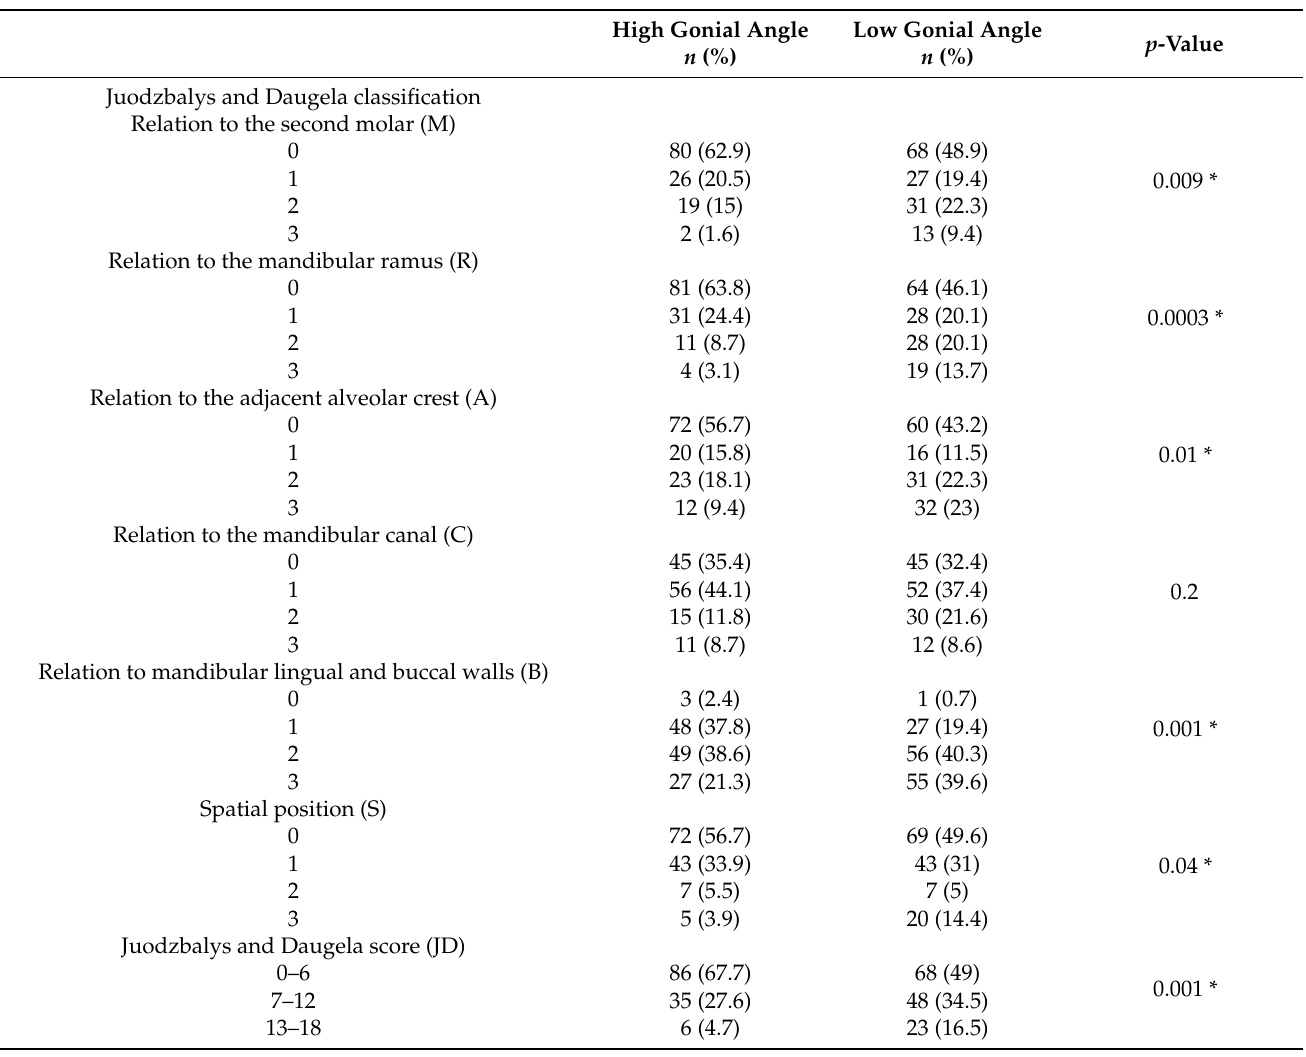
* Statistically significant p -values ( p <